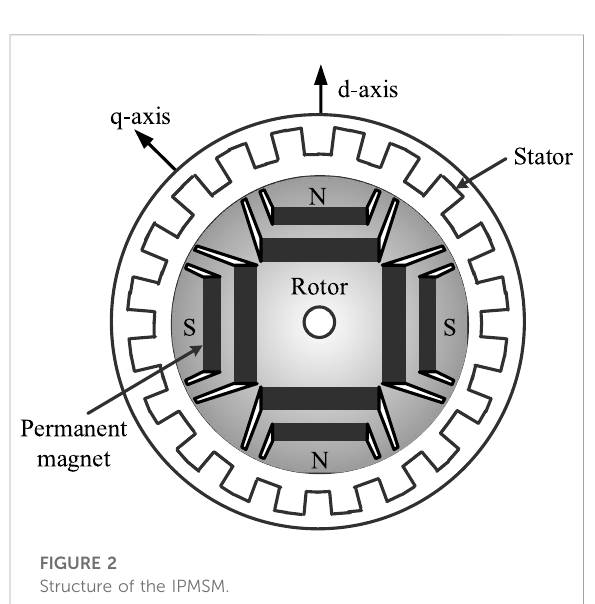
FIGURE 2 Structure of the